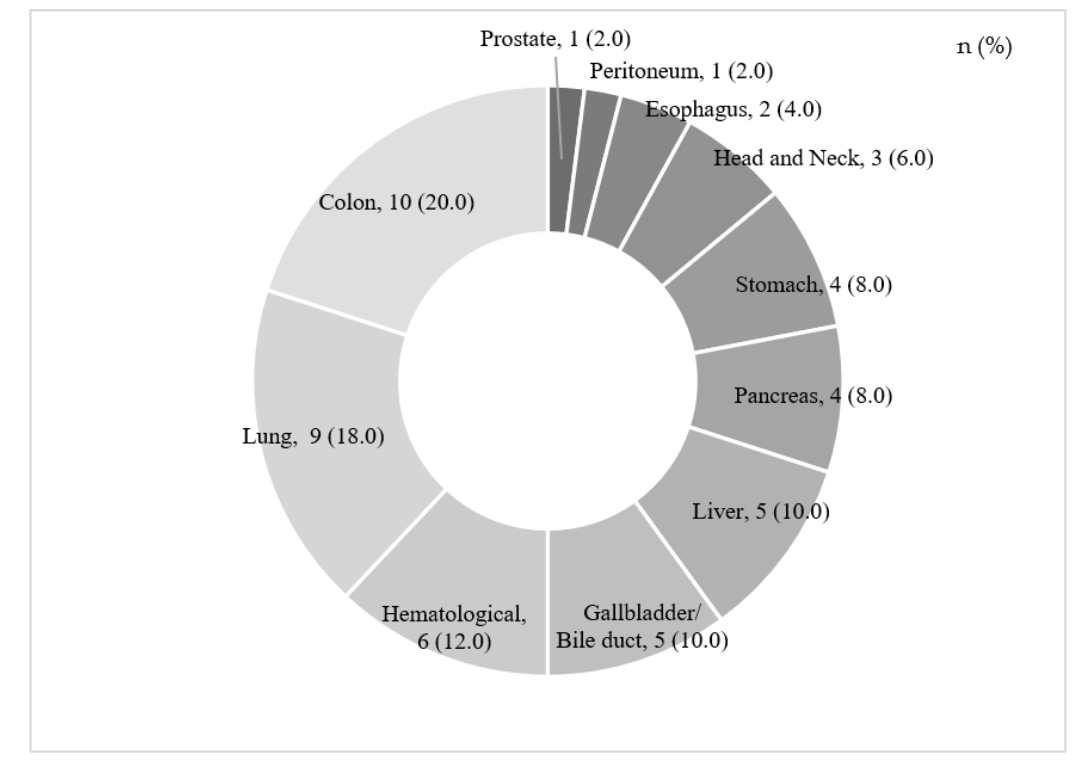
Figure 1. Cancer site ( n = 50). Healthcare 2022 , 10 , x FOR PEER REVIEW